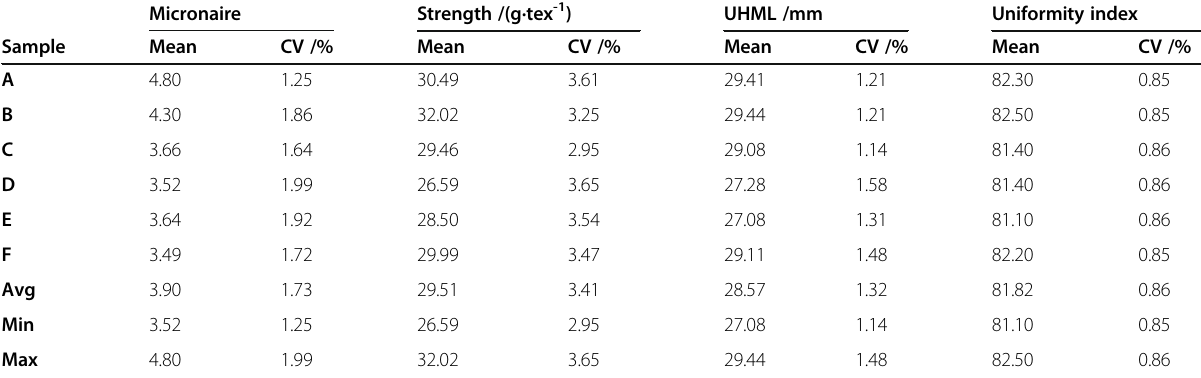
Table 7 Instrument variance for typical HVI properties